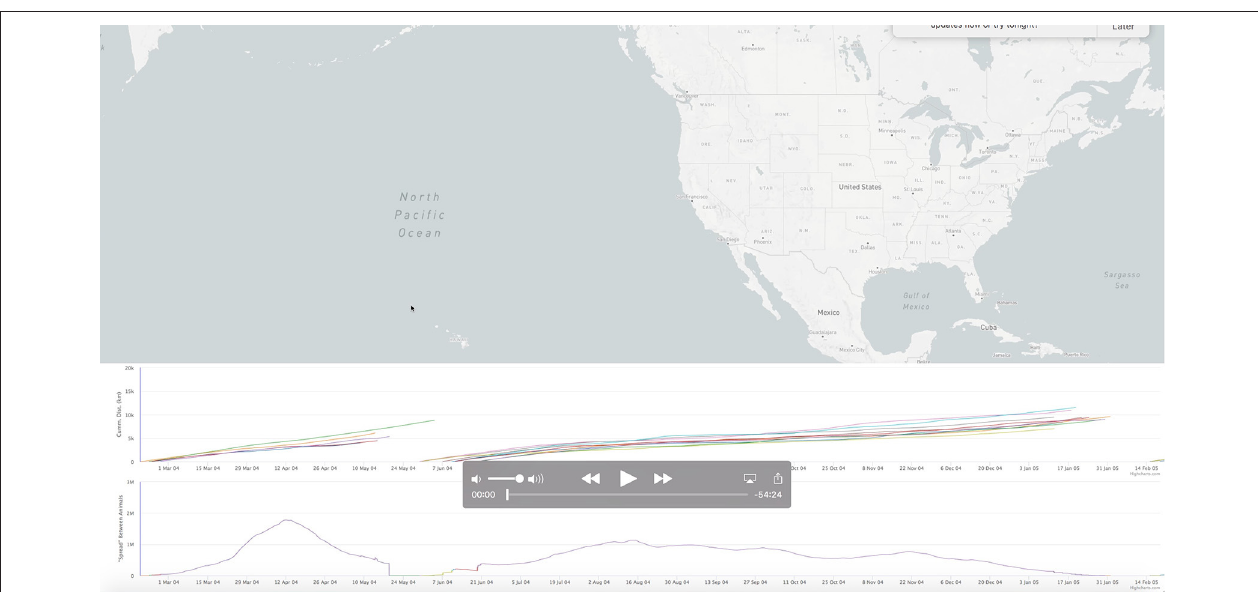
FIGURE 5 | Clickable video showing the trajectories of individual animals across the Northeastern Pacific Ocean, along with the corresponding sonification (audio) and the cumulative distance travel and spread of the animals (the data moving along time 0) in the figures below, which correspond to an animation of Figure 2 in this manuscript. The video and audio reproduce the sonification summarizing the 10 year record of northern elephant seal migrations across the Northeastern Pacific Ocean along with the corresponding tracks of the animals and displays showing the cumulative distance travel and group spread (bottom panel). Available online at: